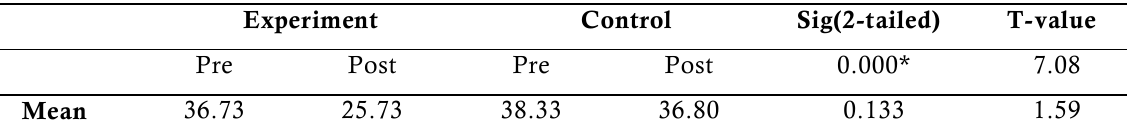
Table 4. Results of paired T-test of pre- and post-expressive writing Experiment